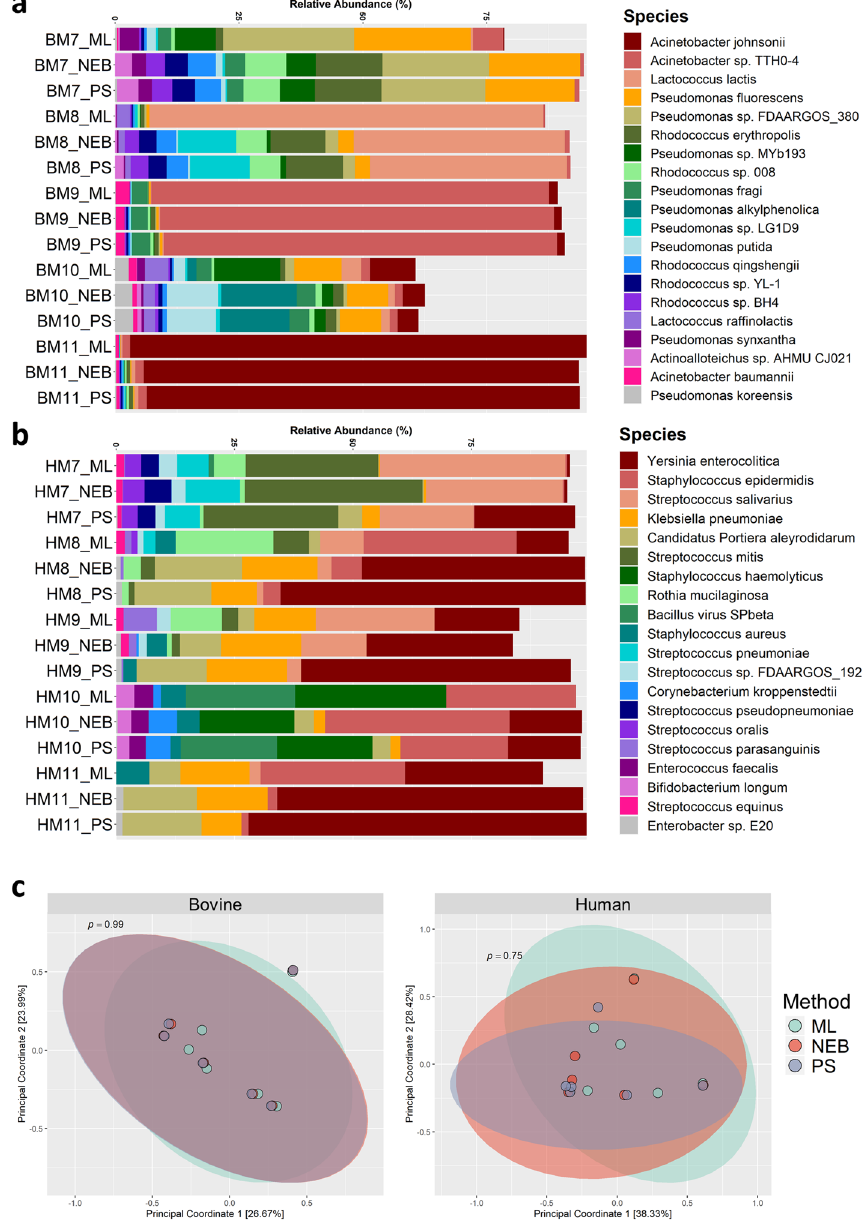
Figure 4. Both the bovine and human milk samples each had similar species level composition and community diversity. Top 20 species composition of all test bovine ( a ) and human ( b ) milk samples using all three extraction methods and clustered based on Bray–Curtis dissimilarity. ( c ) Bray–Curtis dissimilarity plots for both bovine (left) and human (right) milk samples for microbial communities determined using all three methods. Statistical community dissimilarities were calculated using ADONIS. Figures were produced using R 48